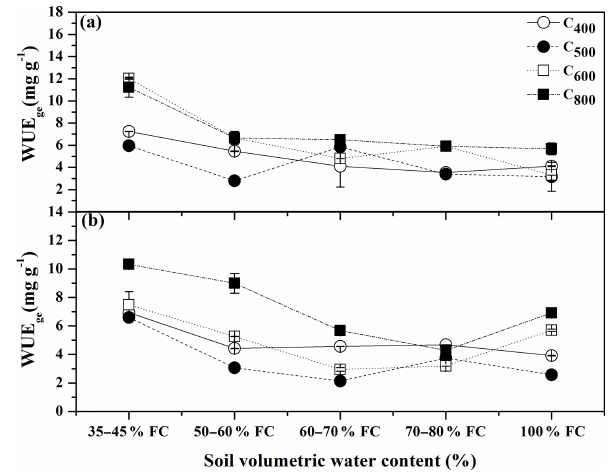
Figure 3. Carbon isotope composition of water-soluble compounds ( δ 13 C WSC ) extracted from leaves of P. orientalis (a) and Q. vari- abilis (b) for four CO 2 concentration × five soil volumetric water content treatments. Means ± SDs, n = 32.